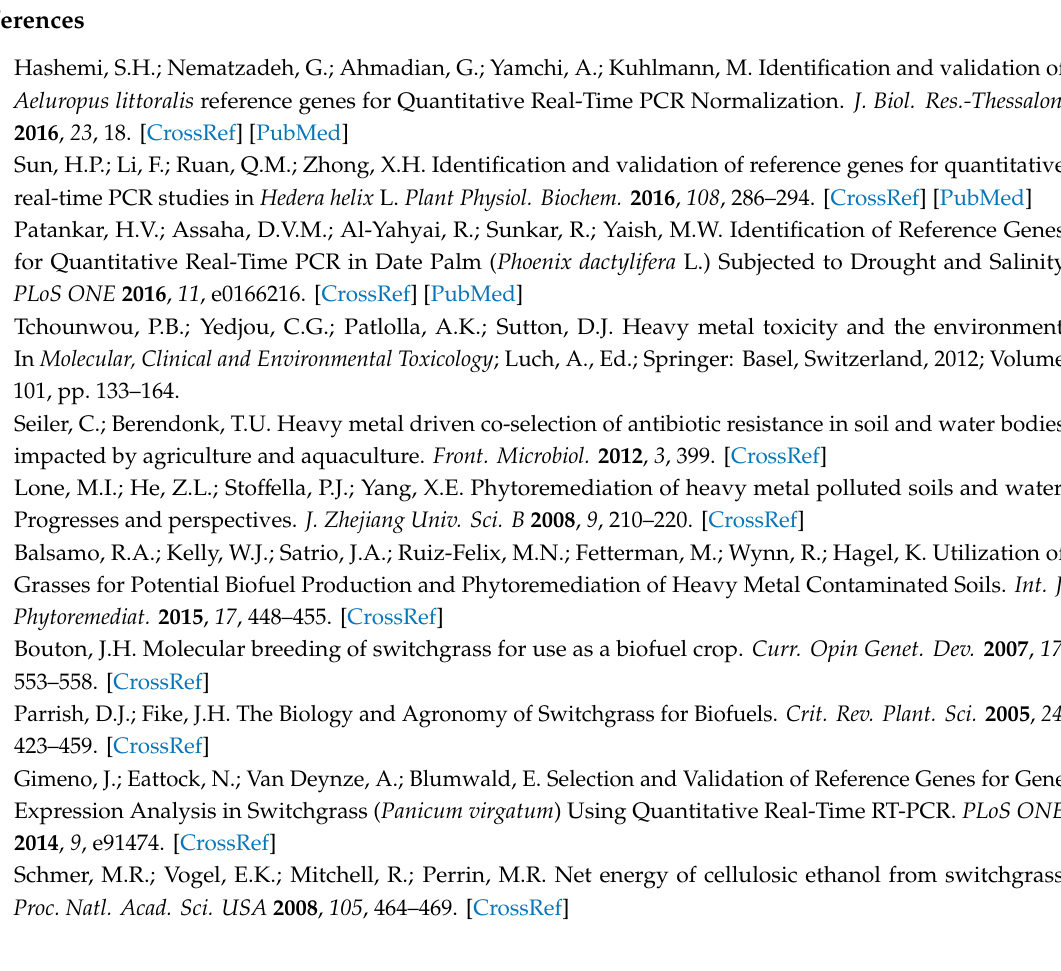
Figure S1: Melting curves for fourteen candidate reference genes. Table S1. Reference genes and primer sequences. Table S2. Ct value for fourteen candidate reference genes under di ff erent heavy metal